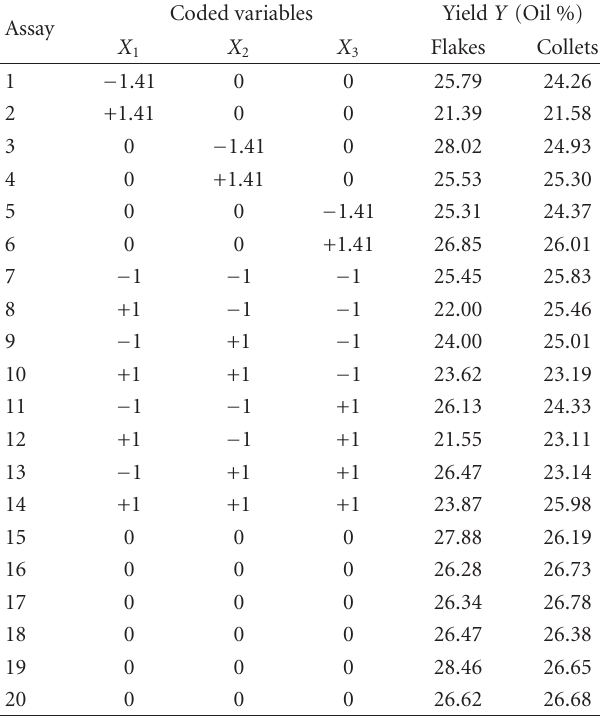
Table 2: Percent of oil yield for experimental design assays. Coded Assay